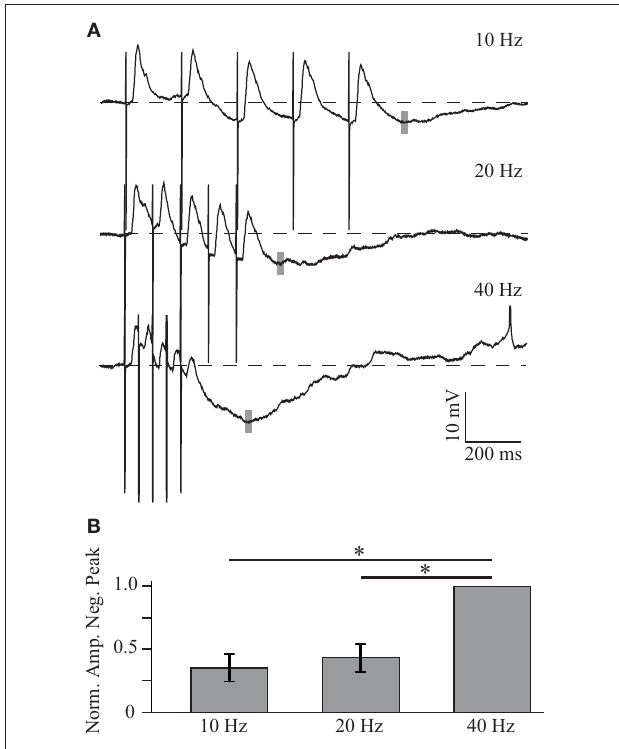
FIgure 5 | Frequency dependent summation of inhibition. (A) Average responses to trains of five BLA stimuli at 10, 20, and 40 Hz in a GC neuron depolarized to − 65 mV. The negative peak of the post-train inhibitory response is larger for higher frequencies of stimulation. The gray shaded line indicates the position of the negative peak in this neuron. (B) Histogram showing the normalized amplitude of the negative peak following trains of stimulation. x -axis: stimulation frequency, y -axis: normalized amplitude of the negative peak. Data are presented as mean ± SEM and asterisks indicate significant